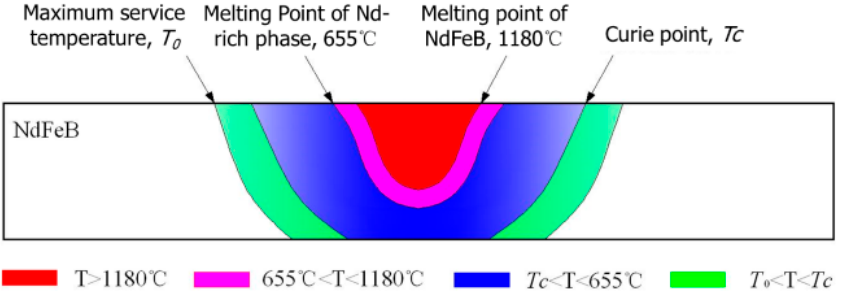
Figure 8. Schematic of temperature distribution and different regions in a spot weld of NdFeB permanent magnet.